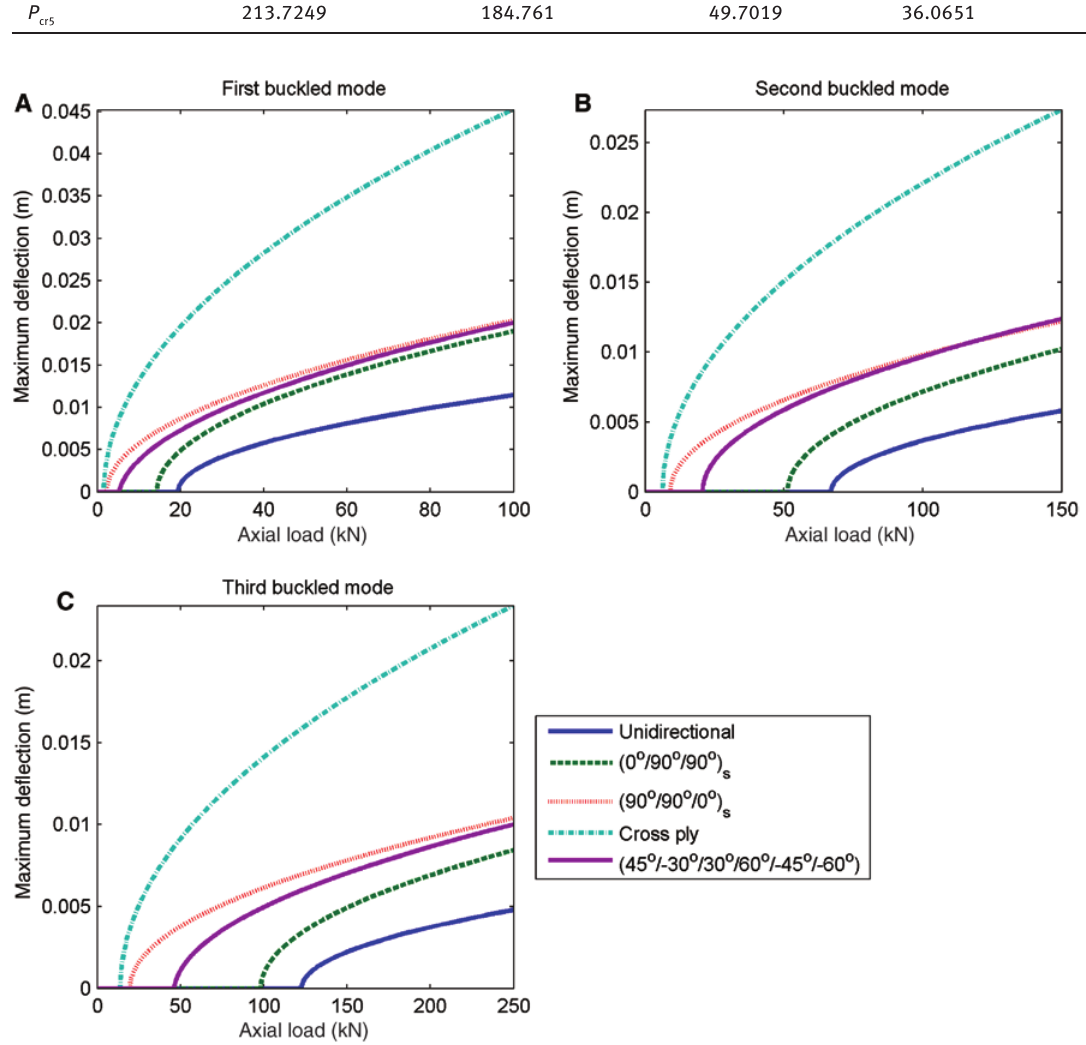
Figure 1 Static bifurcation diagrams of the first three buckled configurations for different laminates of an SS